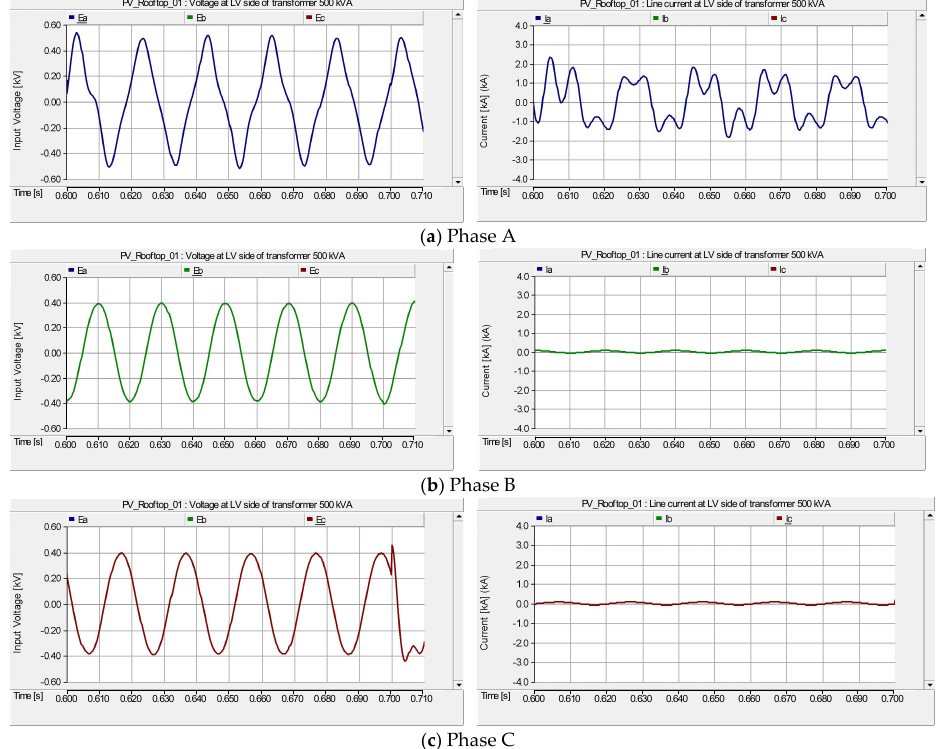
Figure 23. The voltage and current at the LV side (0.4 kV) transformer 500 kVA when the BRKA close circuit is at 0.6